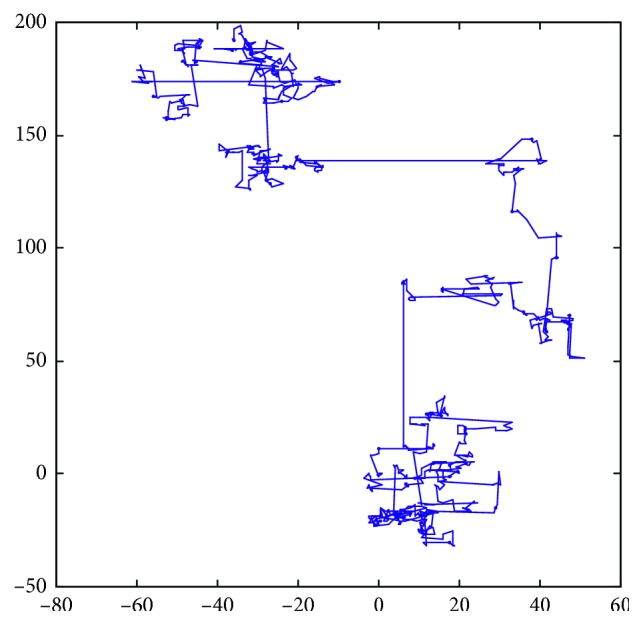
Levy flight tracks.